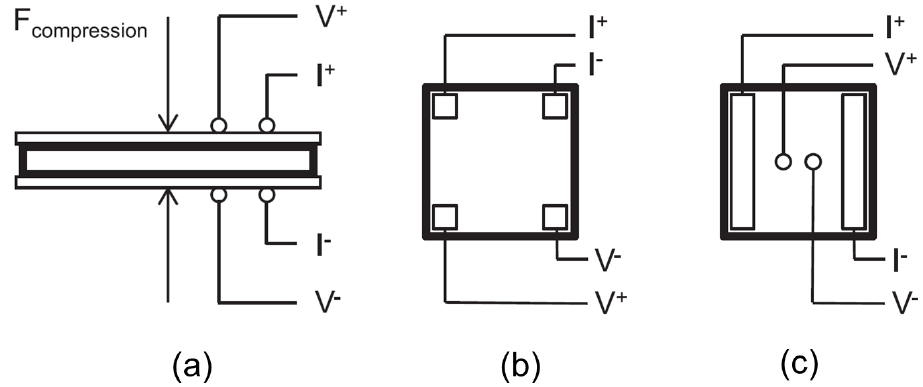
Figure 13. Four-point-probe electrode arrangements for TP ( a ) and IP in square ( b ) and linear ( c ) configurations. Reprinted from the work in